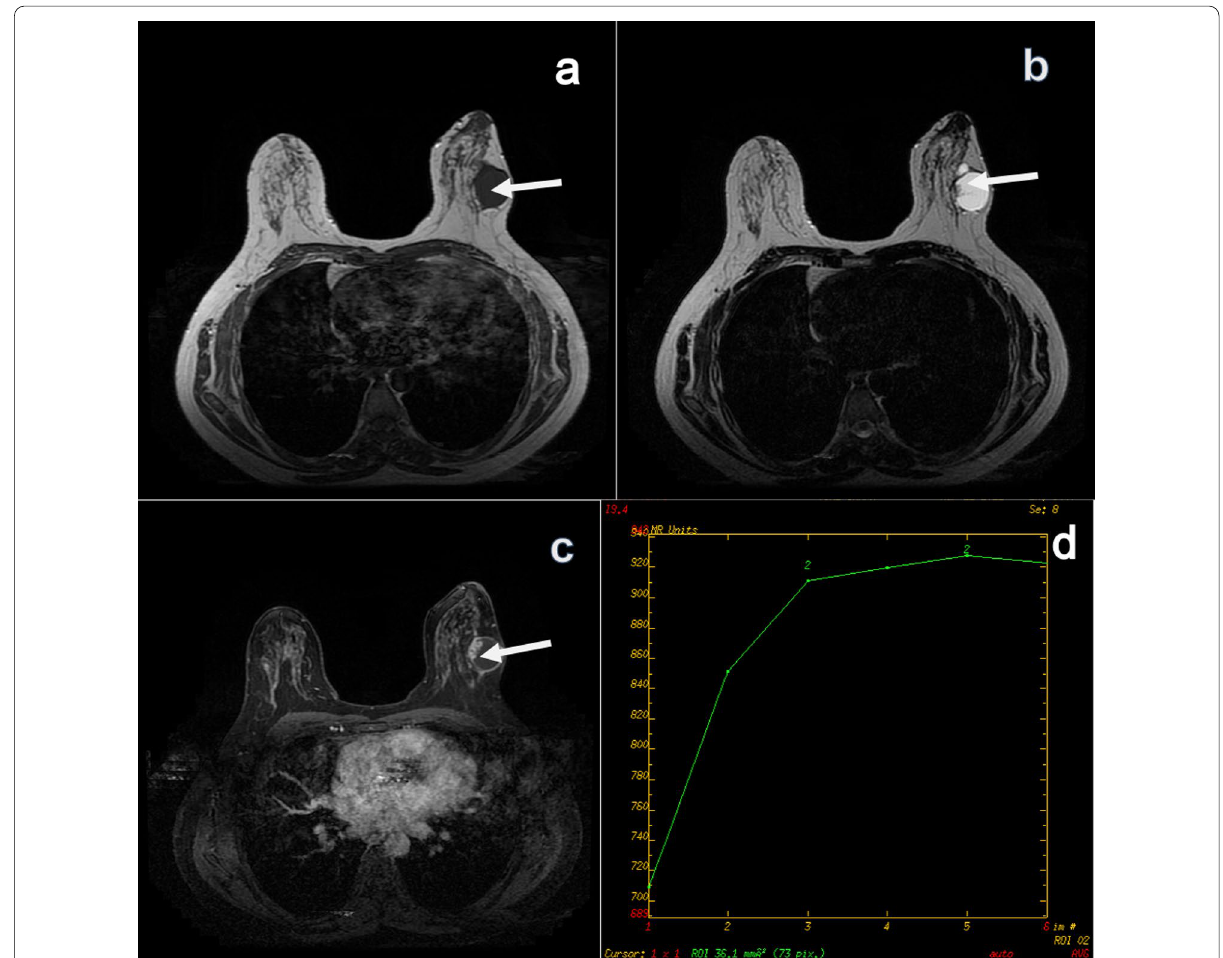
Fig. 3 MRI showing solid component appearing T1 isointense ( a ), T2 hypointense ( b ), post contrast enhancing lesion ( c ), type II kinetic curve ( d